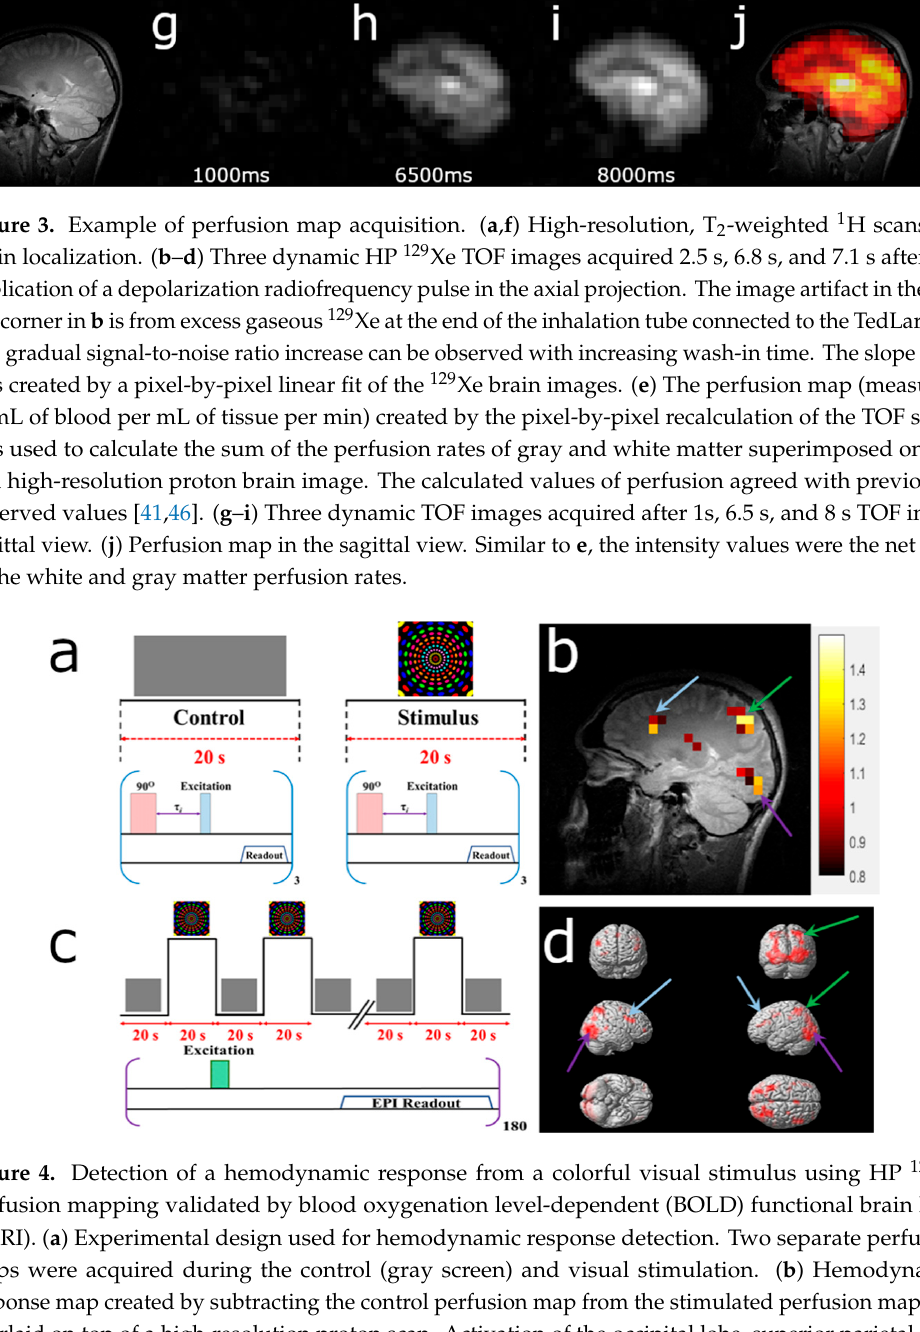
Figure 3. Example of perfusion map acquisition. ( a , f ) High-resolution, T 2 -weighted 1 H scans for brain localization. ( b – d ) Three dynamic HP 129 Xe TOF images acquired 2.5 s, 6.8 s, and 7.1 s after the application of a depolarization radiofrequency pulse in the axial projection. The image artifact in the top left corner in b is from excess gaseous 129 Xe at the end of the inhalation tube connected to the TedLar bag. The gradual signal-to-noise ratio increase can be observed with increasing wash-in time. The slope map was created by a pixel-by-pixel linear fit of the 129 Xe brain images. ( e ) The perfusion map (measured in mL of blood per mL of tissue per min) created by the pixel-by-pixel recalculation